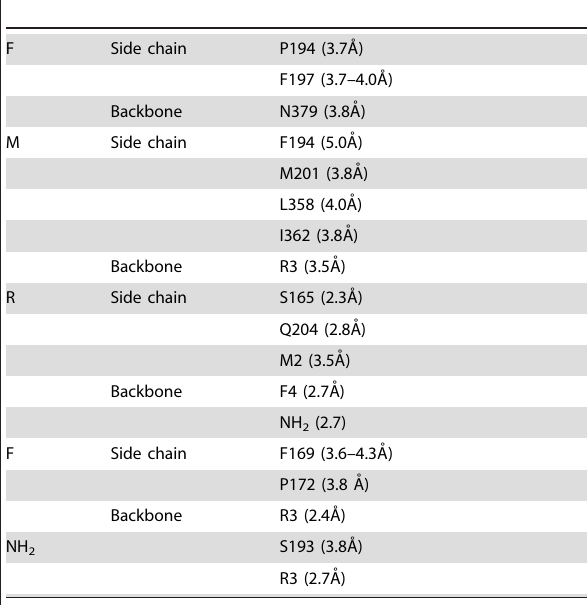
Table 3. FMRF-NH 2 ligand-receptor contact sites, pose B a